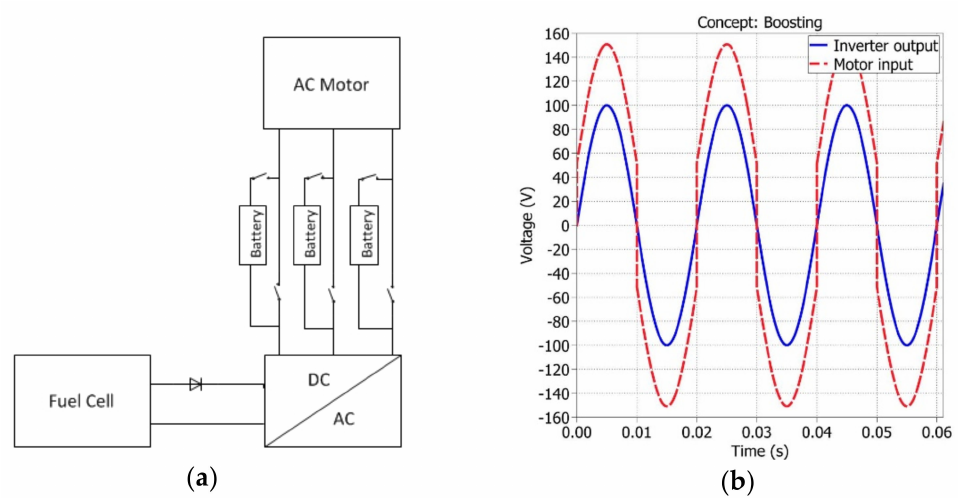
Figure 2. AC hybrid concept [23]. ( a ) AC hybrid topology. ( b ) Voltage boosting by AC